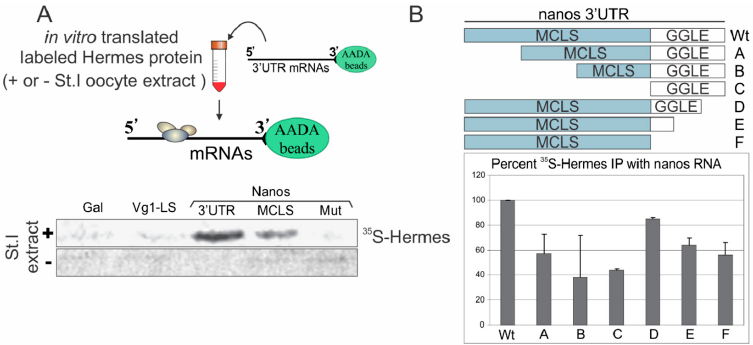
Figure 2. Hermes/Rbpms specifically associates with nanos RNA in a UGCAC dependent manner. ( A ) Hermes/Rbpms interacts with nanos but not Vg1 RNA. Vg1 3 ′ UTR Localization Experimental design is shown at top. Vg1 Localization Signal (LS), nanos1 3 ′ UTR, nanos Mitochondrial Cloud Localization Signal (MCLS), and a nanos mutant MCLS (mut) were tested for Hermes/Rbpms binding. Individual RNAs were immobilized on AADA agarose beads and mixed with in vitro translated Hermes/Rbpms protein labeled with 35 S-methionine. Bound proteins were analyzed by SDS-PAGE and autoradiography. Galactosidase (Gal) RNA served as a negative control. Hermes/Rbpms only bound the nanos1-3 ′ UTR and only when reactions included stage I/II oocyte extracts and not reticulocyte lysates alone. Note: the 3 ′ UTR binds more Hermes/Rbpms than the MCLS alone suggesting the GGLE may also bind Hermes/Rbpms; ( B ) Both the MCLS and GGLE are required for wild-type levels of Hermes/Rbpms binding and require stage I oocyte extract. The deletion mutants diagramed were immobilized on AADA beads and analyzed as described in Methods. Error bars indicate standard deviation of three experiments. Hermes/Rbpms binding to the full-length nanos 3 ′ UTR is set at 100%. Note: both regions contribute to Hermes binding.